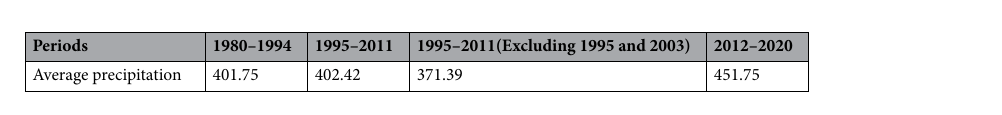
Table 3. Average precipitation (mm) in different periods in Dahai Basin